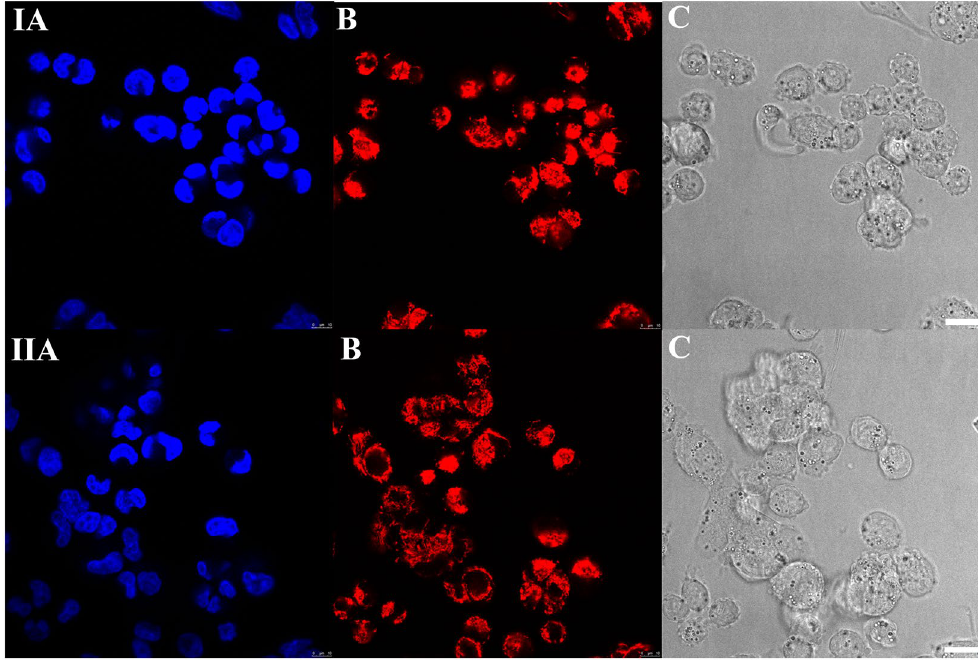
Figure 5. Confocal microphotographs of HCT-116 cells with nucleus stained with Hoechst 33342 ( A ) and mitochondria stained with TMRE ( B ). Cells were treated for 5 h with 1 µ M of Pt(IV)diOA (upper row I). Control, untreated cells are shown in the row II (bottom) of the figure. Cells stained with Hoechst 33342 or TMRE were visualized in the bright field mode ( C ). Scale bars represent 20 µ m. Figures are the representatives of at least 10 individual scans of different sample areas. Three independent experiments were performed in triplicate.